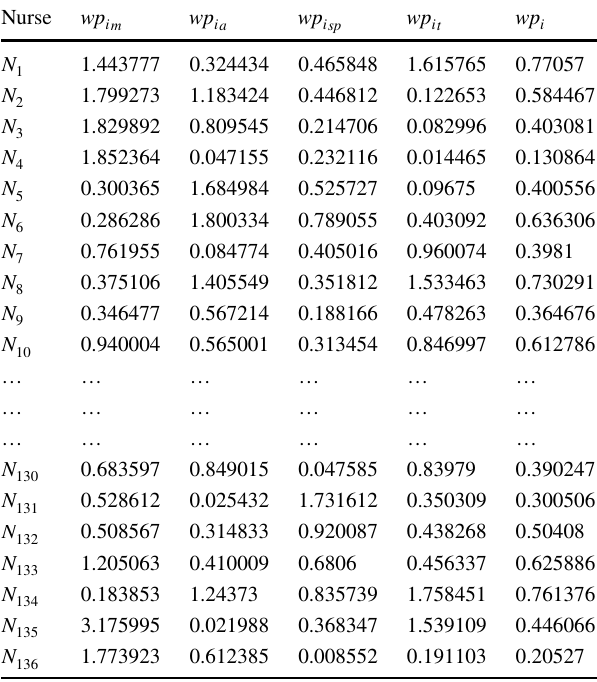
( e ) T and wp c i , j